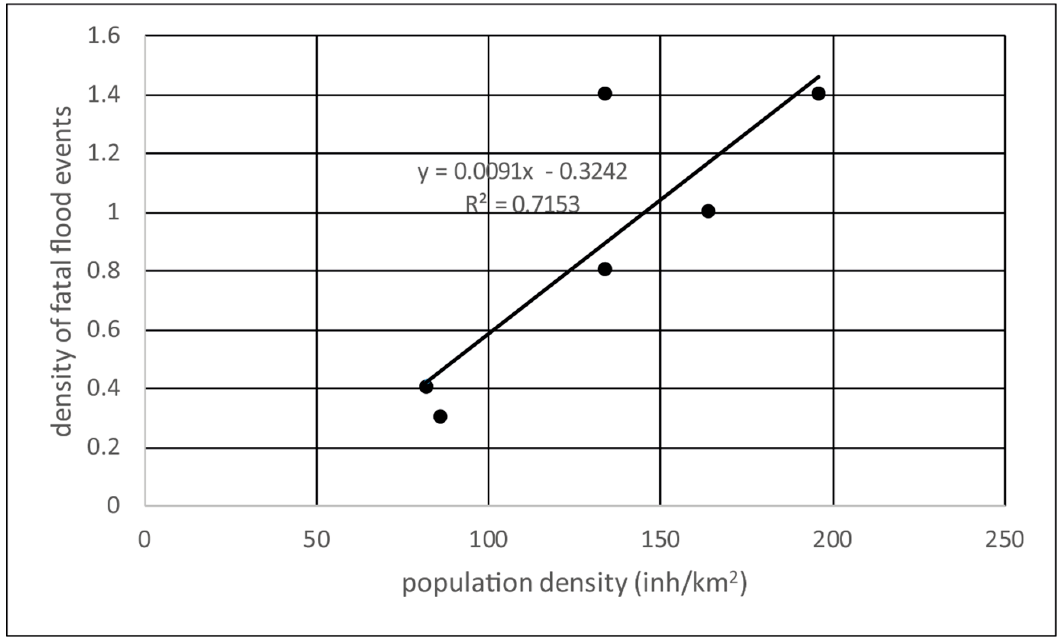
Figure 14. Relationship between the population density and the density of fatal events.